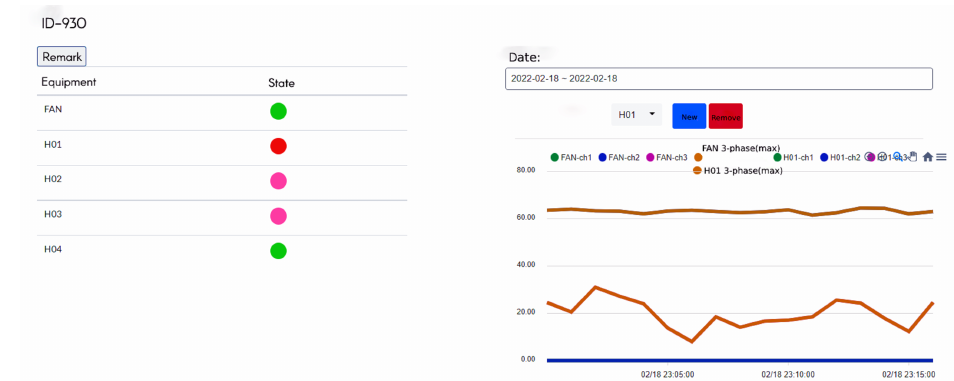
Figure 5. Hot-pressing furnace monitoring and electricity consumption record system.